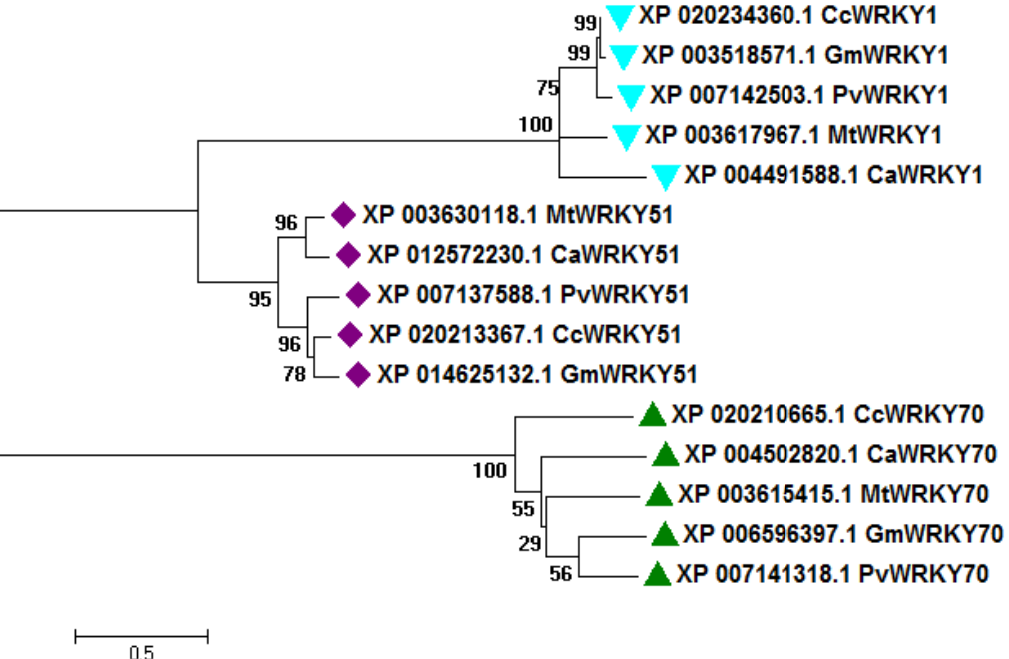
Figure 1. Phylogenetic tree of Type I, II, and III CcWRKY proteins (one representative each) identified in pigeonpea along with homologs from different legume species including Cajanus cajan (Cc), Cicer arietinum (Ca), Medicago truncatula (Mt), Glycine max (Gm), and Phaseolus vulgaris (Pv). The tree was generated by the maximum likelihood (ML) method with 1000 bootstrap replicates using the MEGA6 software.